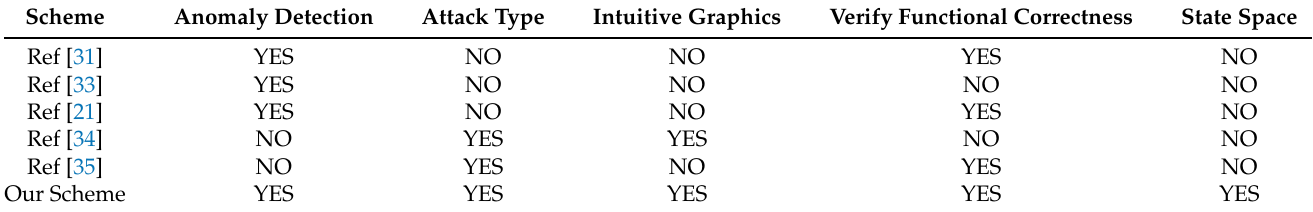
Table 6. Comparison of protocol analysis